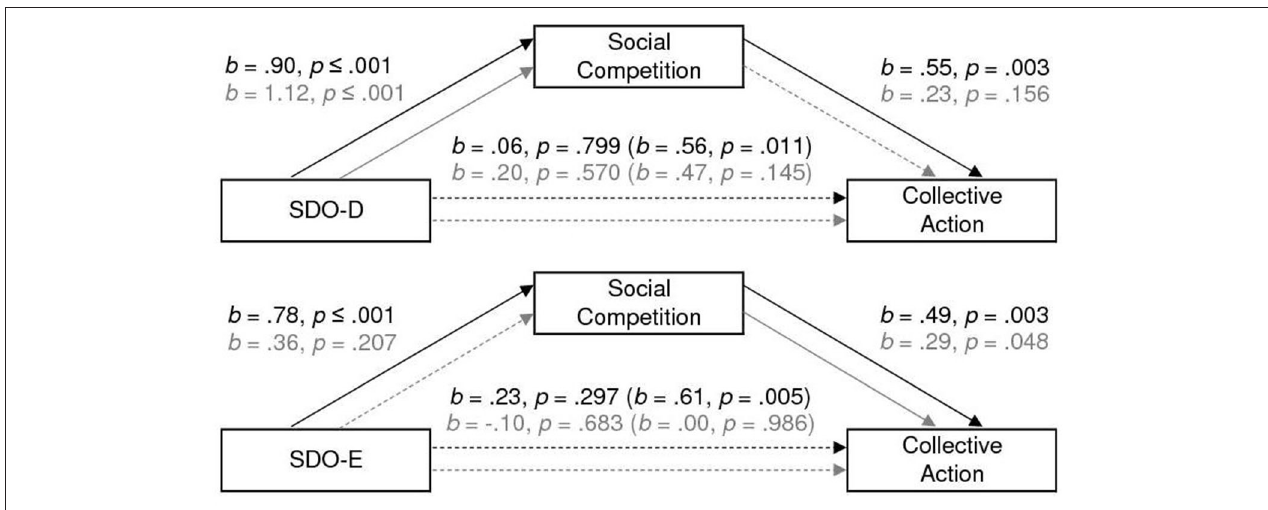
FIGURE 1 | The effect of SDO on collective action mediated by social competition. Coefficients for the high-status condition are in gray. All reported coefficients are unstandardized.